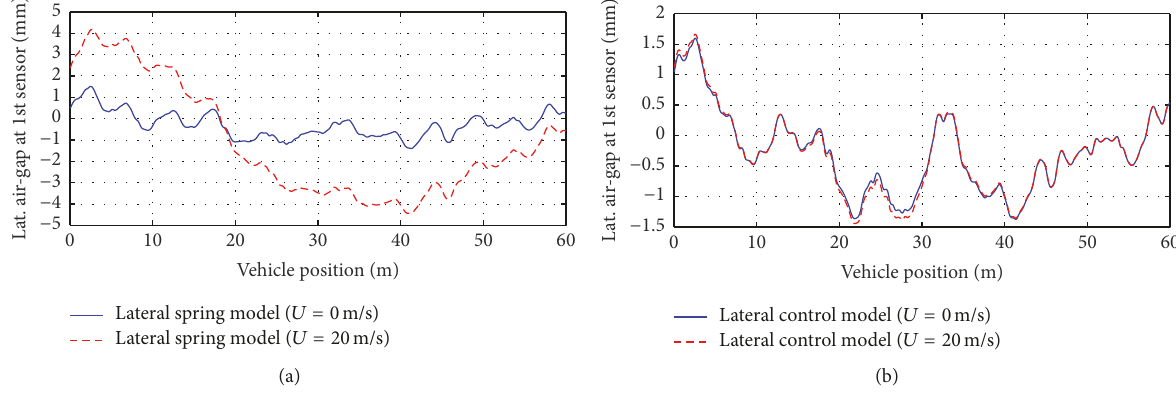
Figure 12: Time history results of lateral air-gap according to wind conditions (vehicle speed: 100km/h): (a) lateral air-gap at 1st sensor of lateral spring model, (b) lateral air-gap at 1st sensor of lateral control